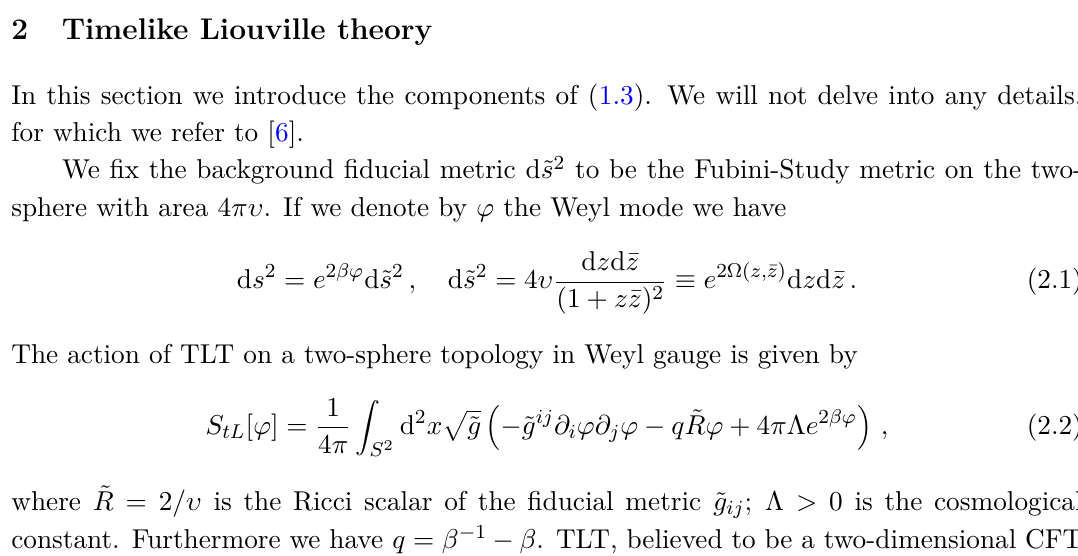
Figure 1 . Type of diagrams surviving at order O ( β 4 )